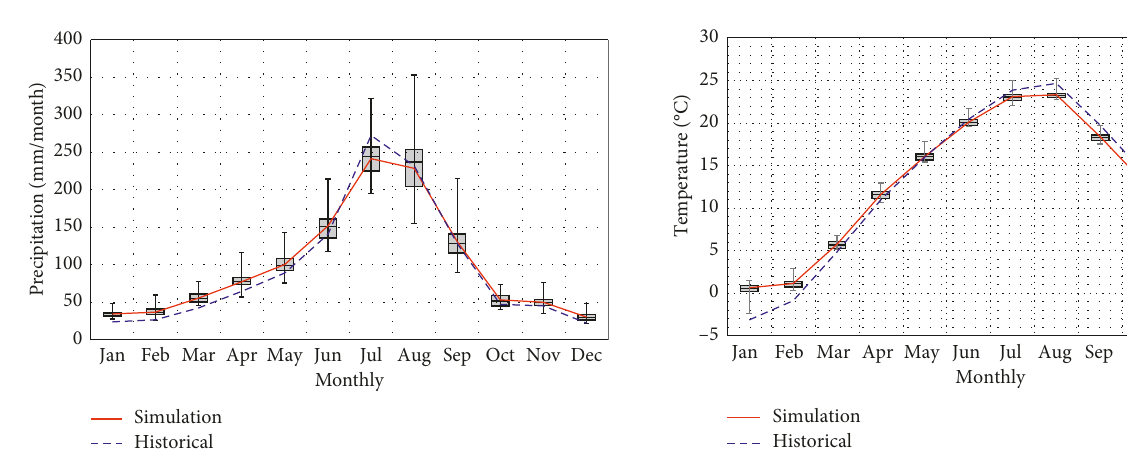
Figure 8: Intermodel variability for monthly precipitation. Figure 9: Intermodel variability for monthly average temperatures.